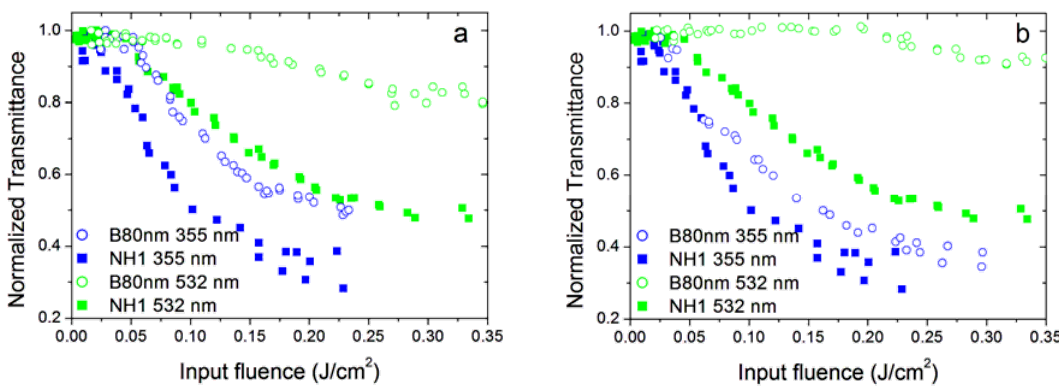
Figure 9. Optical limiting properties of the NH1 sample (dahlia) and B80nm (bud) at the 355 and 532 nm wavelengths: ( a ) for similar values of the linear extinction coefficient (corresponding to nanoparticle concentrations of 0.025 and 0.0125 g/L for dahlias and buds, respectively and ( b ) for the same nanoparticle concentration for both samples (0.025 g/L).